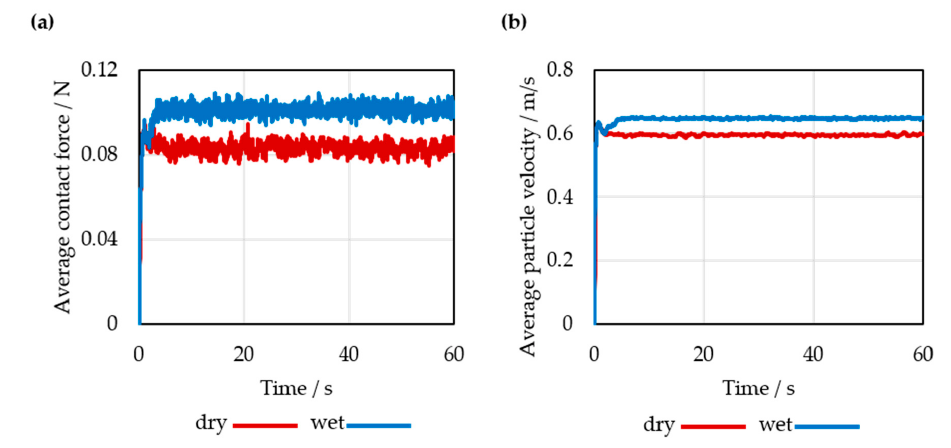
12 of 19 Figure 5. Time-averaged solid volume fraction for the dry case ( a ) and for the wet case ( b ). While the average contact force of the particles stays constant over time for the dry case, it